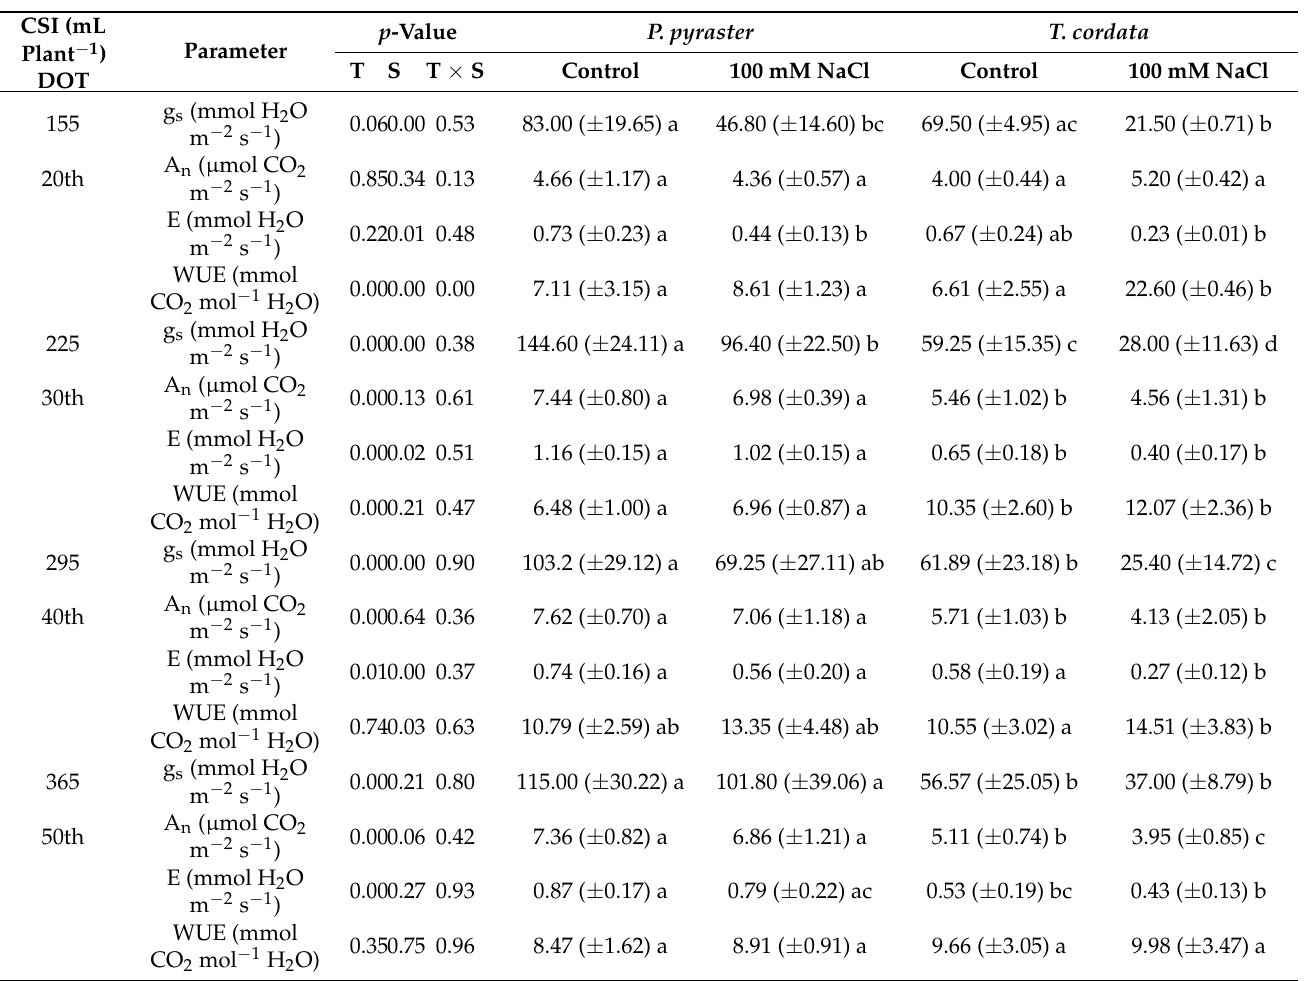
Table 4. The parameters of leaf gas exchange in the leaves of P. pyraster and T. cordata seedlings after 50 days of salt treatment ( n = 5). Mean values followed by different letters are significantly